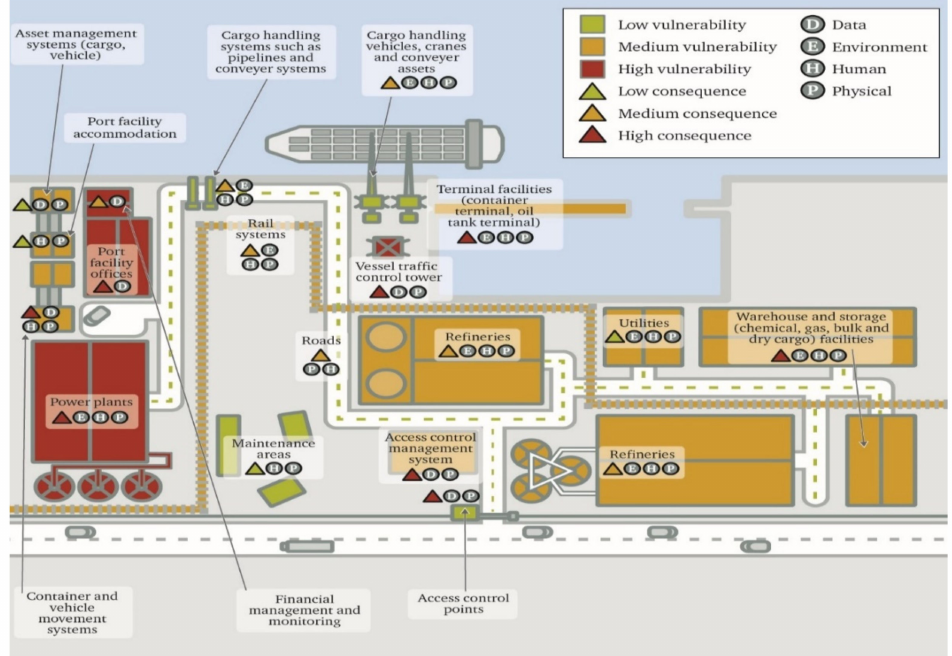
Figure 3. Port Components (Vulnerabilities, Consequences and Affected Fields). Note: This graphical illustration was generated with the support of Chatham House. Source: